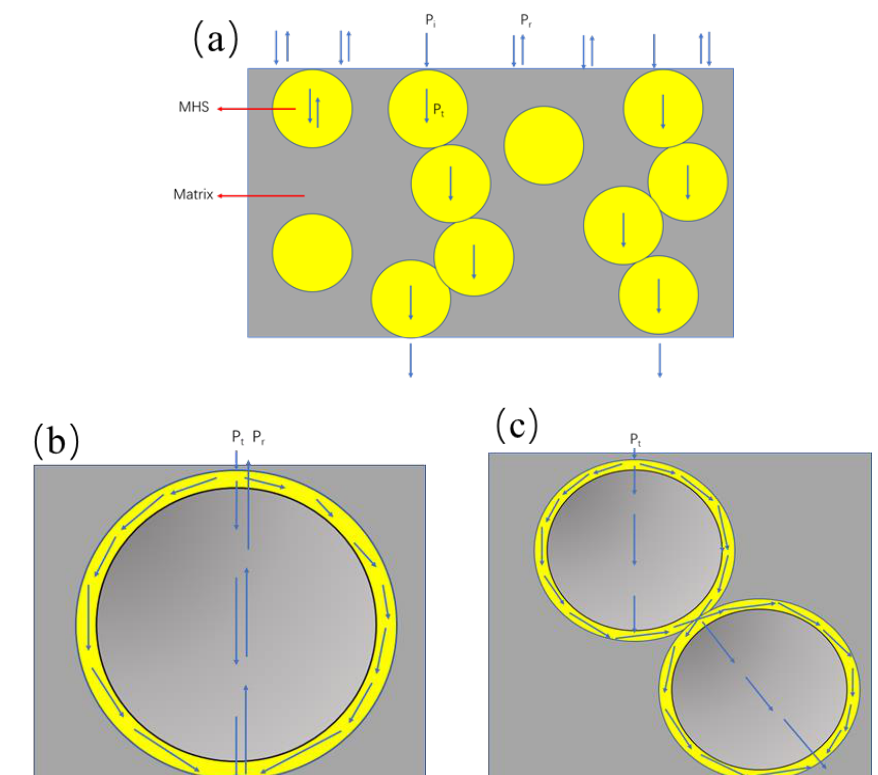
Figure 11. The schematic diagram of the sound waves propagation under the off-resonance condition: ( a ) in the MHSC; ( b ) in the MHS surrounded by the matrix; ( c ) in the MHSs contacted closely.